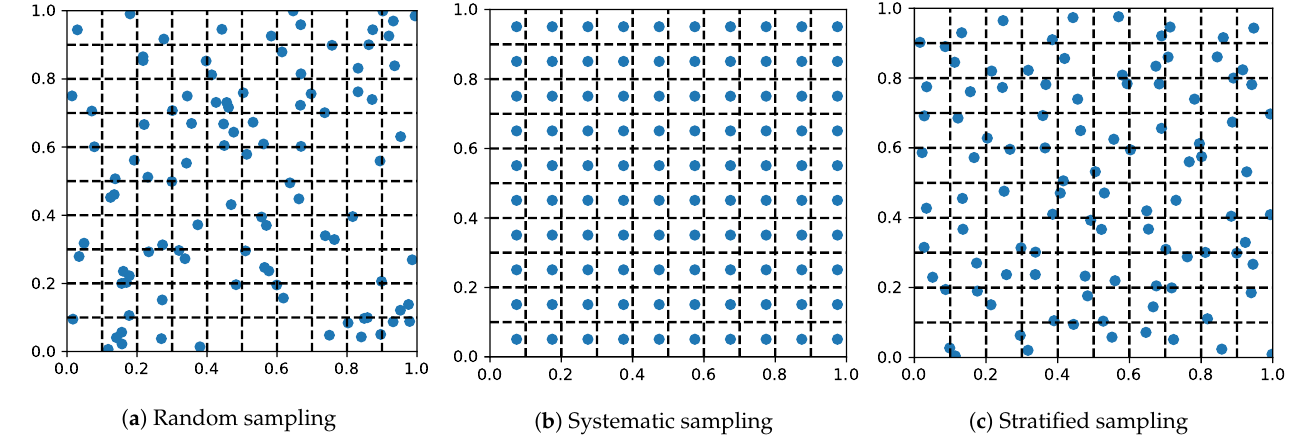
Figure 6. Illustration of model-free sampling